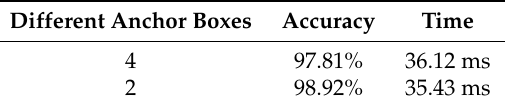
Table 4. The influence of anchor